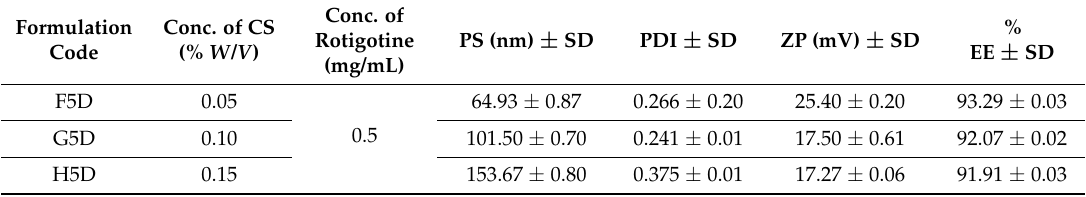
Table 2. Effect of increase in chitosan concentration on particle size, polydispersity index, zeta potential, and entrapment efficiency of rotigotine-loaded nanoparticles ( n =